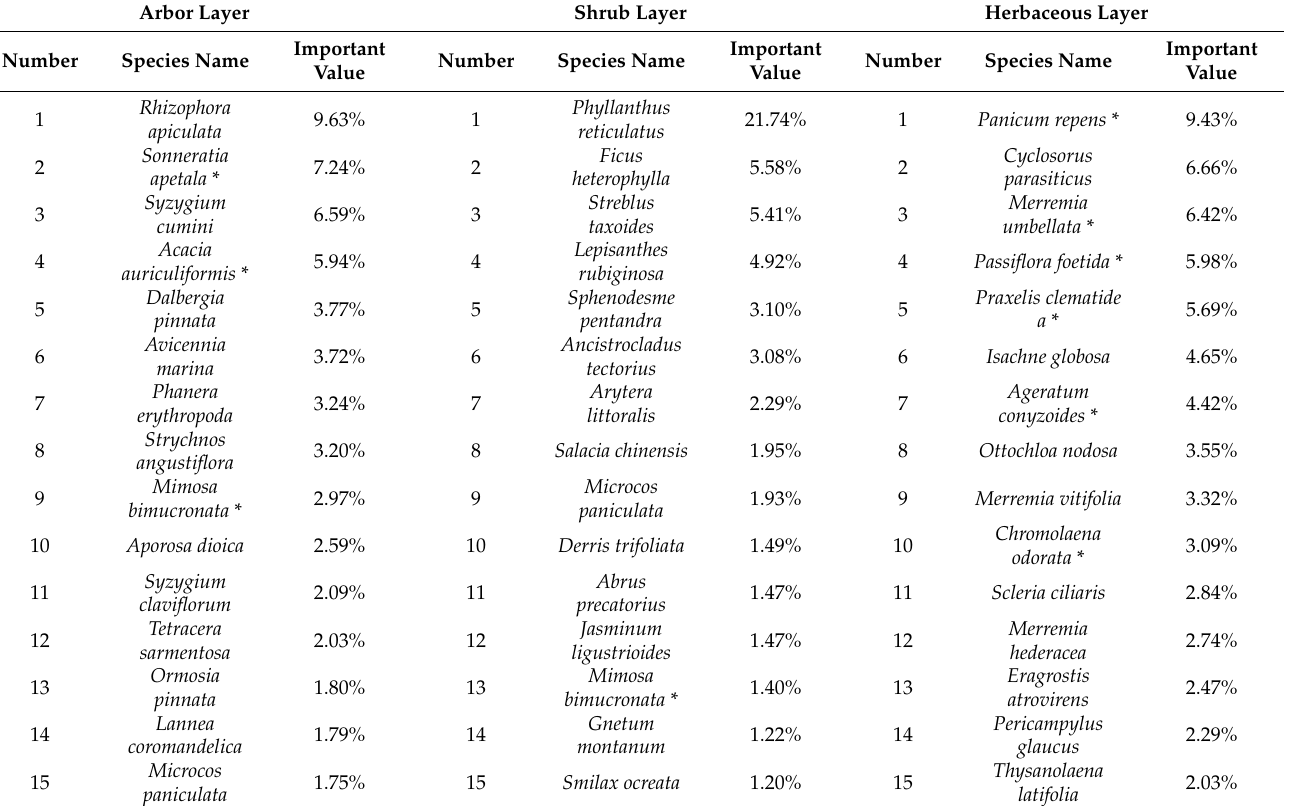
Table 3. The top 15 species with high importance value in each layer; all important values retain 2 digits after the decimal point. * representing exotic plants: species of the invasive level 1 including Mimosa sepiaria, Praxelis clematidea , Ageratum conyzoides, and Chromolaena odorata ; species of